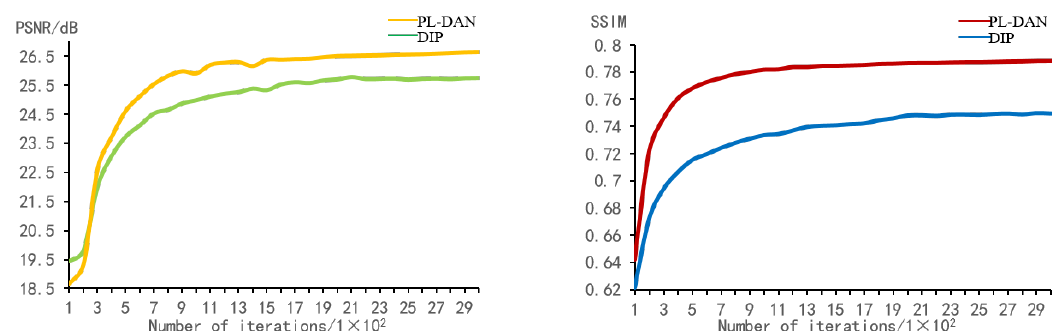
Figure 4. The curves of PSNR and SSIM values versus iteration numbers.